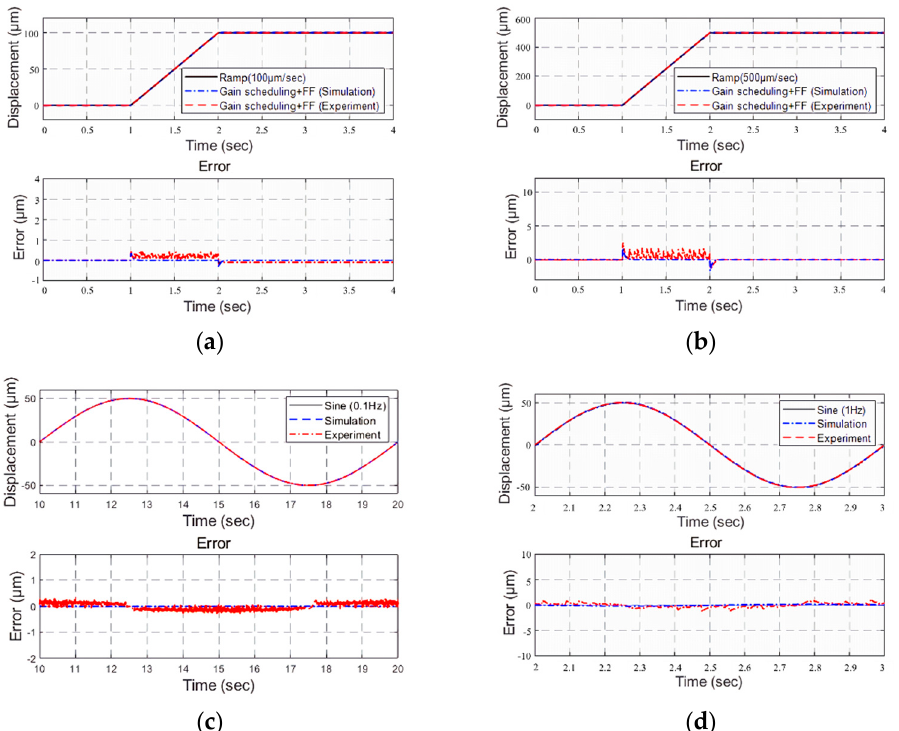
Figure 8. Tracking responses of the motor stage: ( a ) ramp input (100 μ m/s); ( b ) ramp input (500 μ m/s); ( c ) sinusoidal input (0.1 Hz); ( d ) sinusoidal input (0.1 Hz).